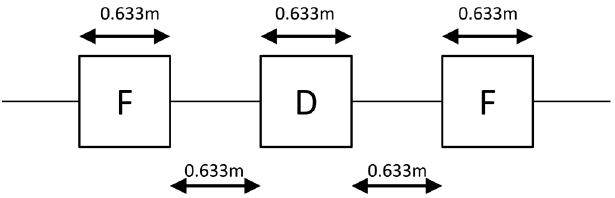
FIG. 15. The carbon lattice.